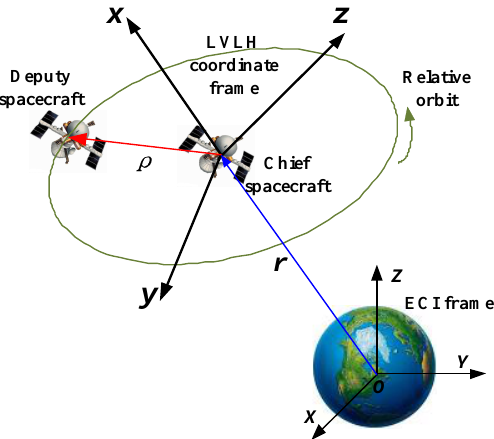
Figure 1. ECI and LVLH coordinate frames for spacecraft formation flying.